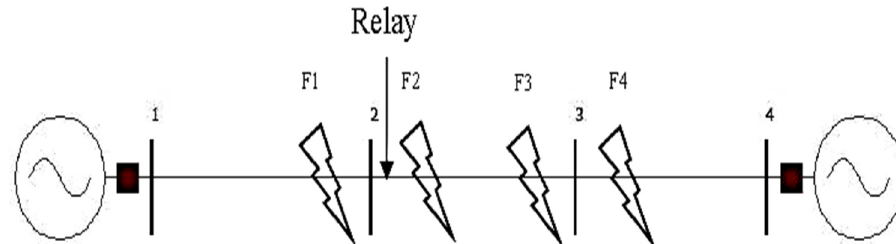
Figure 1. Simple multiline system.